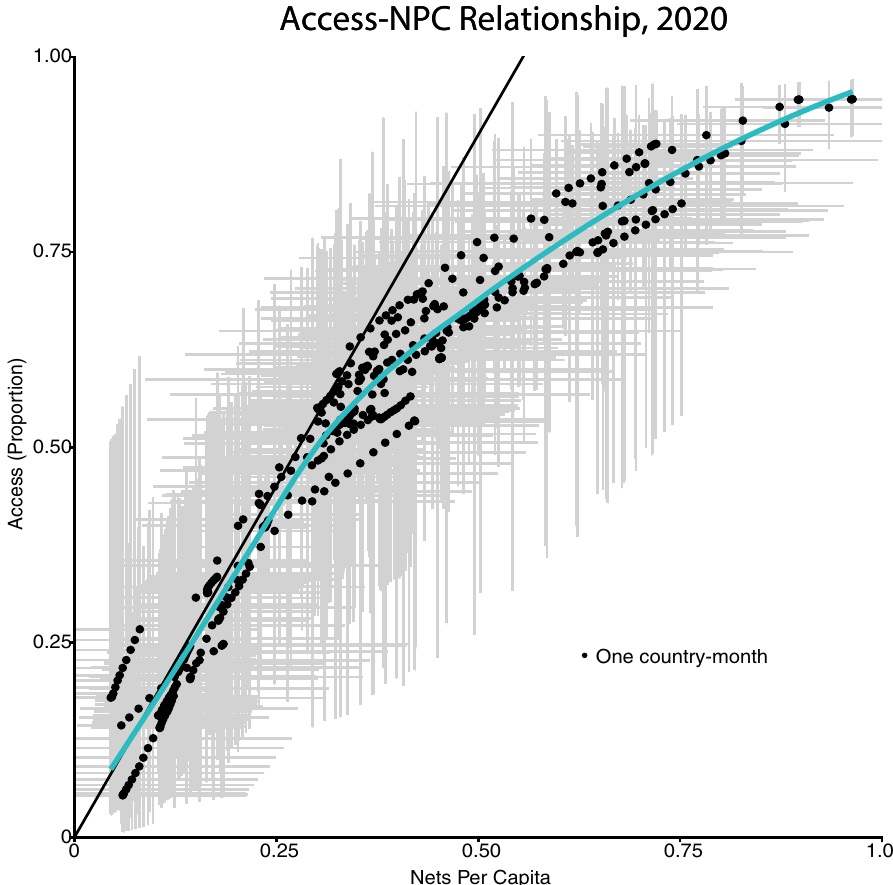
Fig. 4 Relationship between access and nets-per-capita (NPC) in 2020. Each dot represents a modeled country-month, with black dots indicating mean values and gray bars indicating 95% con fi dence intervals for each metric. The solid line has a slope of 1.8, showing the relationship between NPC and access presumed by population-based net procurement decisions. The blue curve shows a Loess fi t through the estimated points. The expected linear relationship between NPC and access holds well at low coverage levels, but the true relationship tapers off at NPC values greater than 0.25 and access over 0.5. This plateauing of access despite high numbers of nets distributed per capita suggests inef fi ciencies or redundancies in net distribution at these coverage levels, such that those who should be receiving nets are still left without